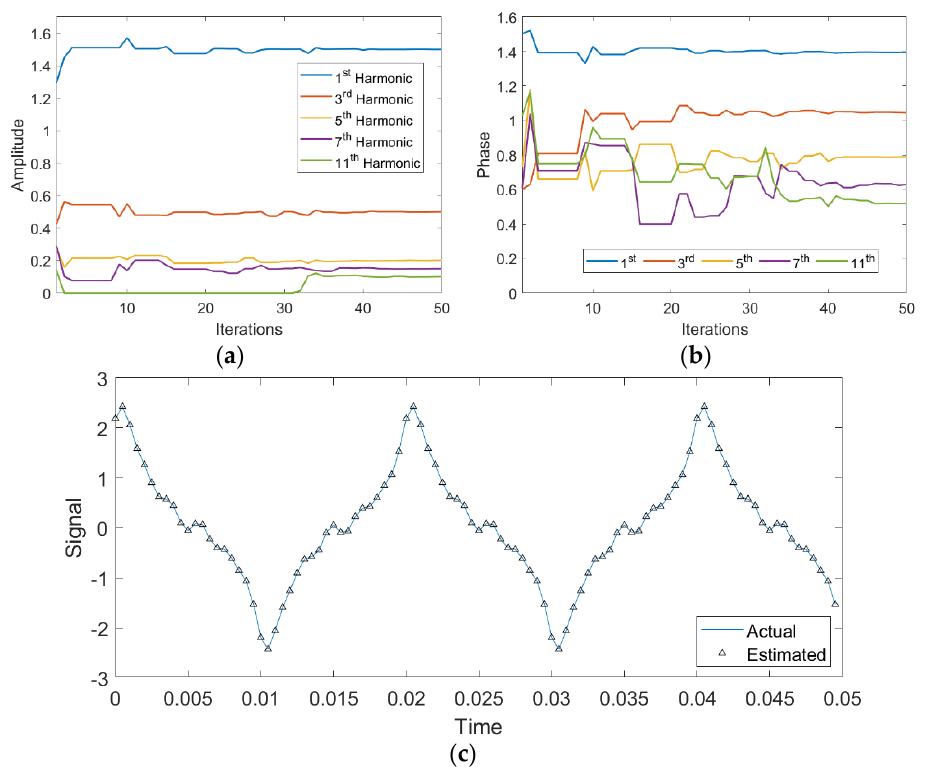
Figure 8. Plots of parameters estimates for 1.0 λ and 70 dB δ . ( a ) amplitude ( b ) phase ( c ) curve- fitting.